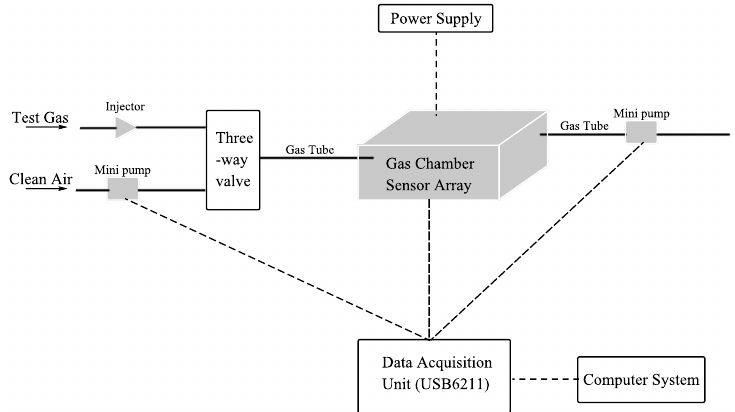
Figure 3. Layout of self-assembled E-nose system.